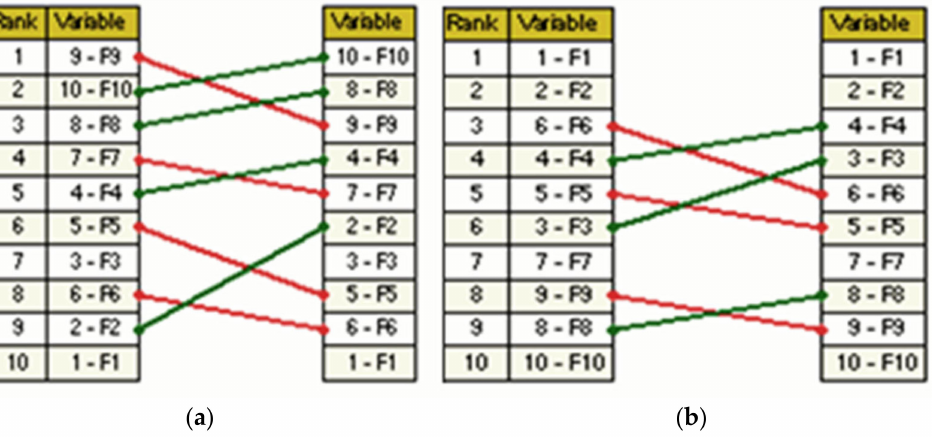
Figure 6. The ranking comparison of SCFs among factors according to their influences ( a ) and dependencies ( b ).